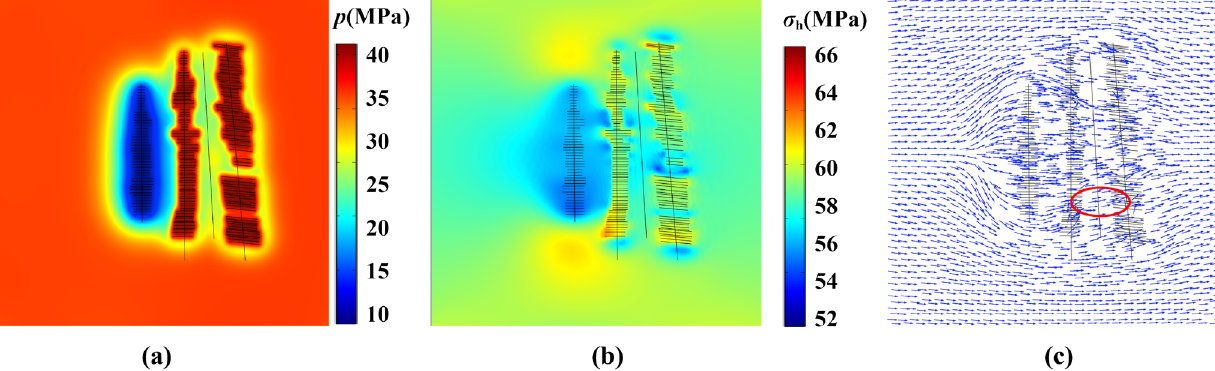
Fig. 13 Pressure and stress field ( ξ i = 0.5, soaking for 100 days): a formation pressure p ; b minimum horizontal stress; c orientation of maximum horizontal stress σ H